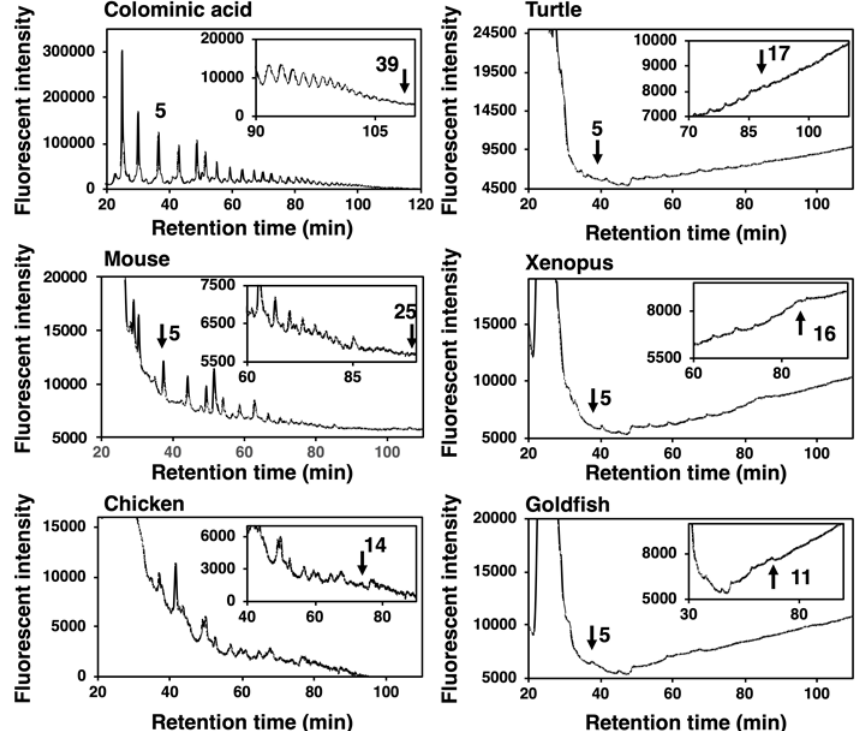
Figure 6. MH–FAEC analysis (Oligo-analysis) of brain homogenates from five vertebrate brains. Brains from five vertebrates (mouse, chicken, turtle, xenopus, goldfish, n = 1) were used. Brain homogenates (100 µg as protein) were subjected to mild acid hydrolysis followed by DMB derivatization. DMB-labeled oligo/polySia chains were applied to an anion exchange chromatography-HPLC analysis.